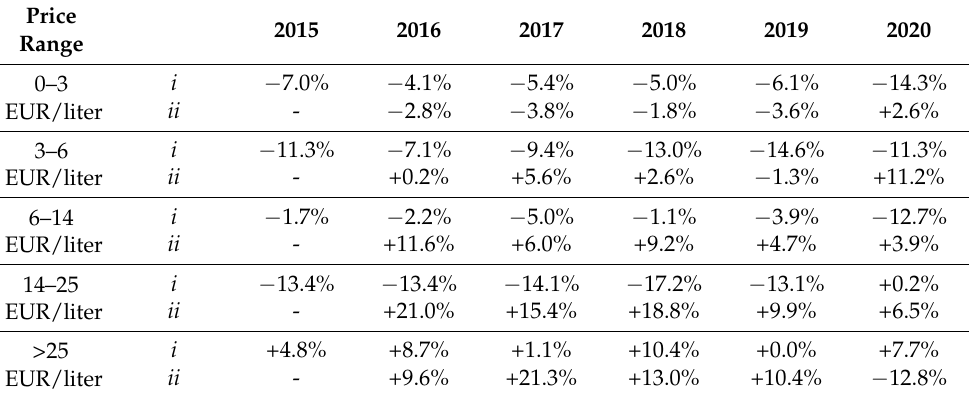
Figure 5. Wine sales in value (millions of EUR) by price range. Table 7. Percentage change of wine sales in value by price range compared to the previous period: for each year, ( i ) the variation of b2 compared to b1, and ( ii ) the variation of b2 compared to b2 of the previous year.